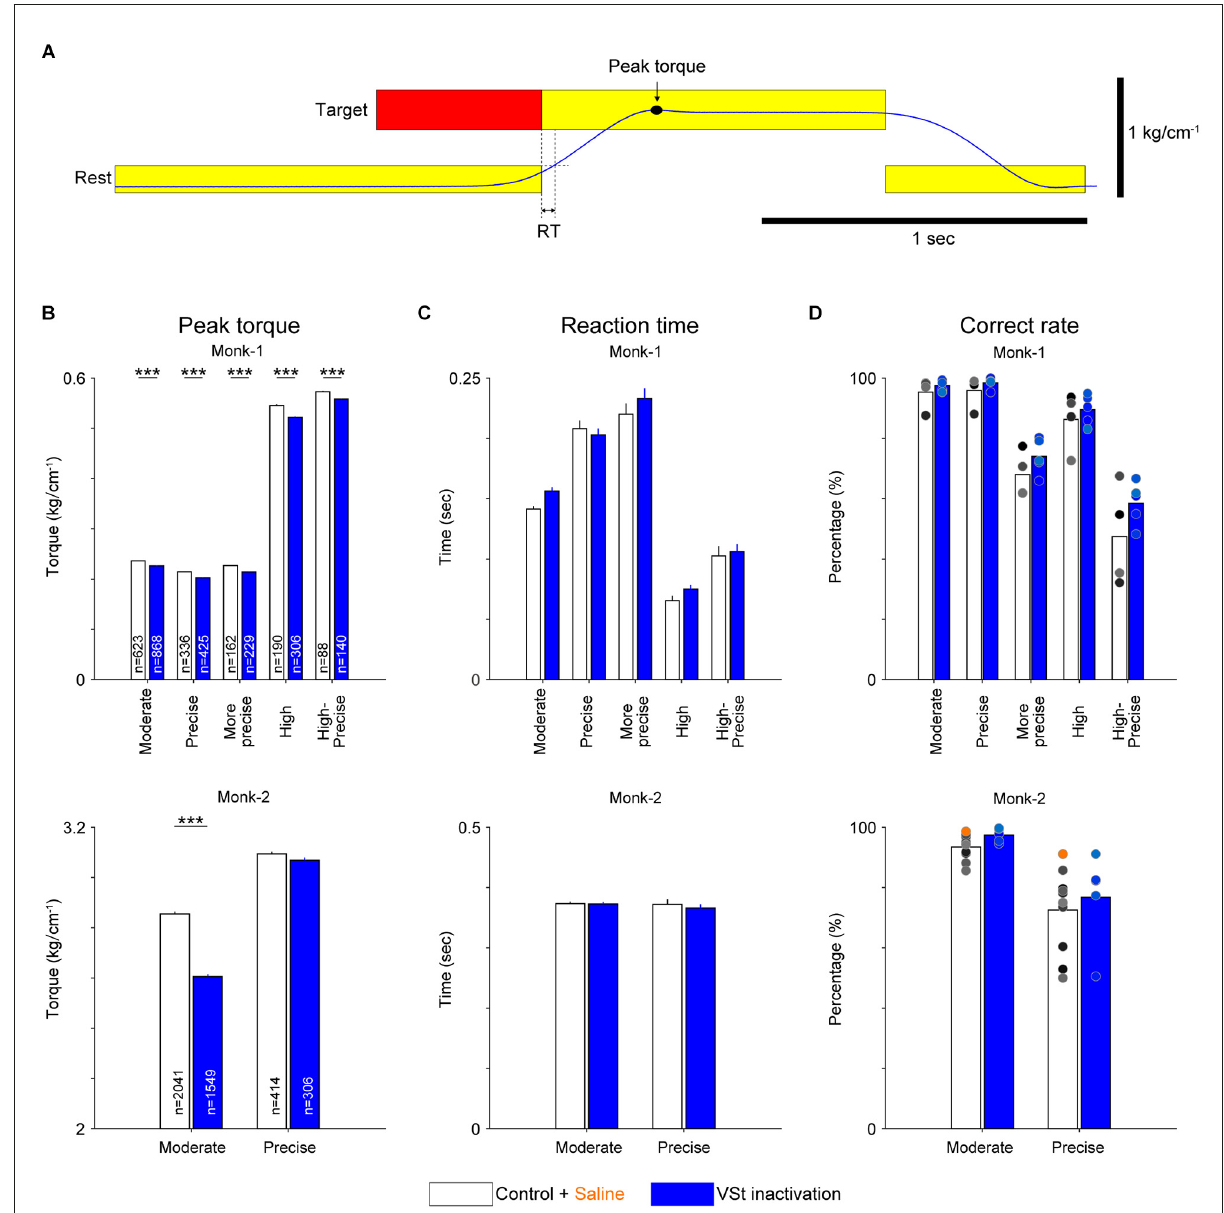
FIGURE3 Population data of the effect of VSt inactivation on motor performances. (A) Definition of peak torque and reaction time (RT). Torque output is shown in blue. Peak torque is a maximum value of torque output revealed by a filled circle and arrow. RT is defined as the time window between the timing of the go cue and the timing when the cursor, which is associated with torque output, exceeded the rest position. (B) Peak wrist torque for each target in both monkeys (upper, Monk-1; lower, Monk-2). ‘n’ in each bar graph indicates the number of trials pooled across sessions. (C) RT for each target in both monkeys (upper, Monk-1; lower, Monk-2). In (B) and (C) , bar graphs and error bars indicate the mean and standard error of the mean, respectively. Wilcoxon-signed rank test (control vs. VSt inactivation) with Bonferroni correction was conducted for each target pair. *** P < 0.001. (D) Correct rate for each target in both monkeys (upper, Monk-1; lower, Monk-2). Individual dots indicate the results of each session (Monk-1: four Control sessions, five VSt inactivation sessions; Monk-2: nine Control sessions, one saline session, five VSt inactivation